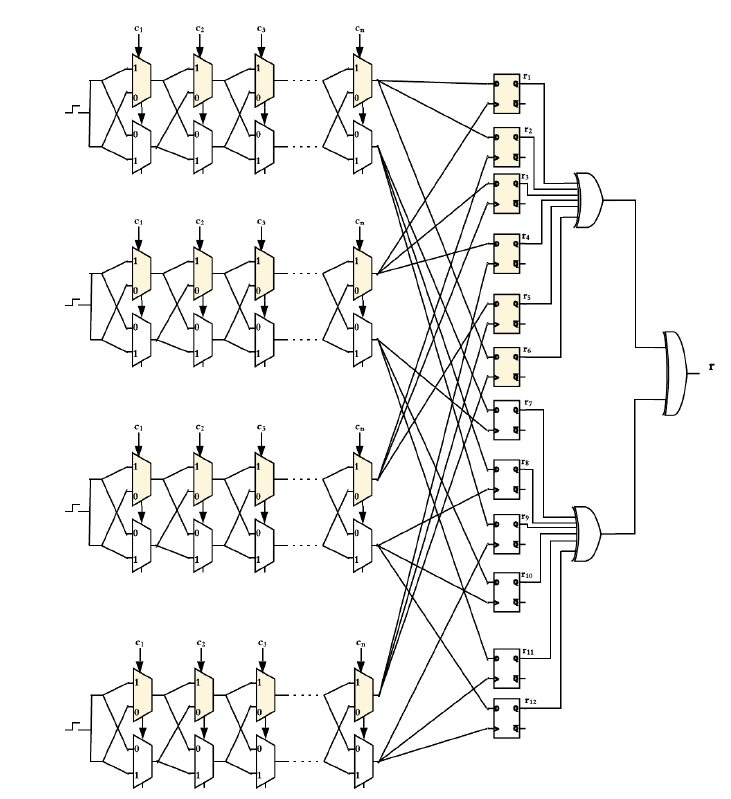
Figure 6. Structure of 4-1 Double Arbiter